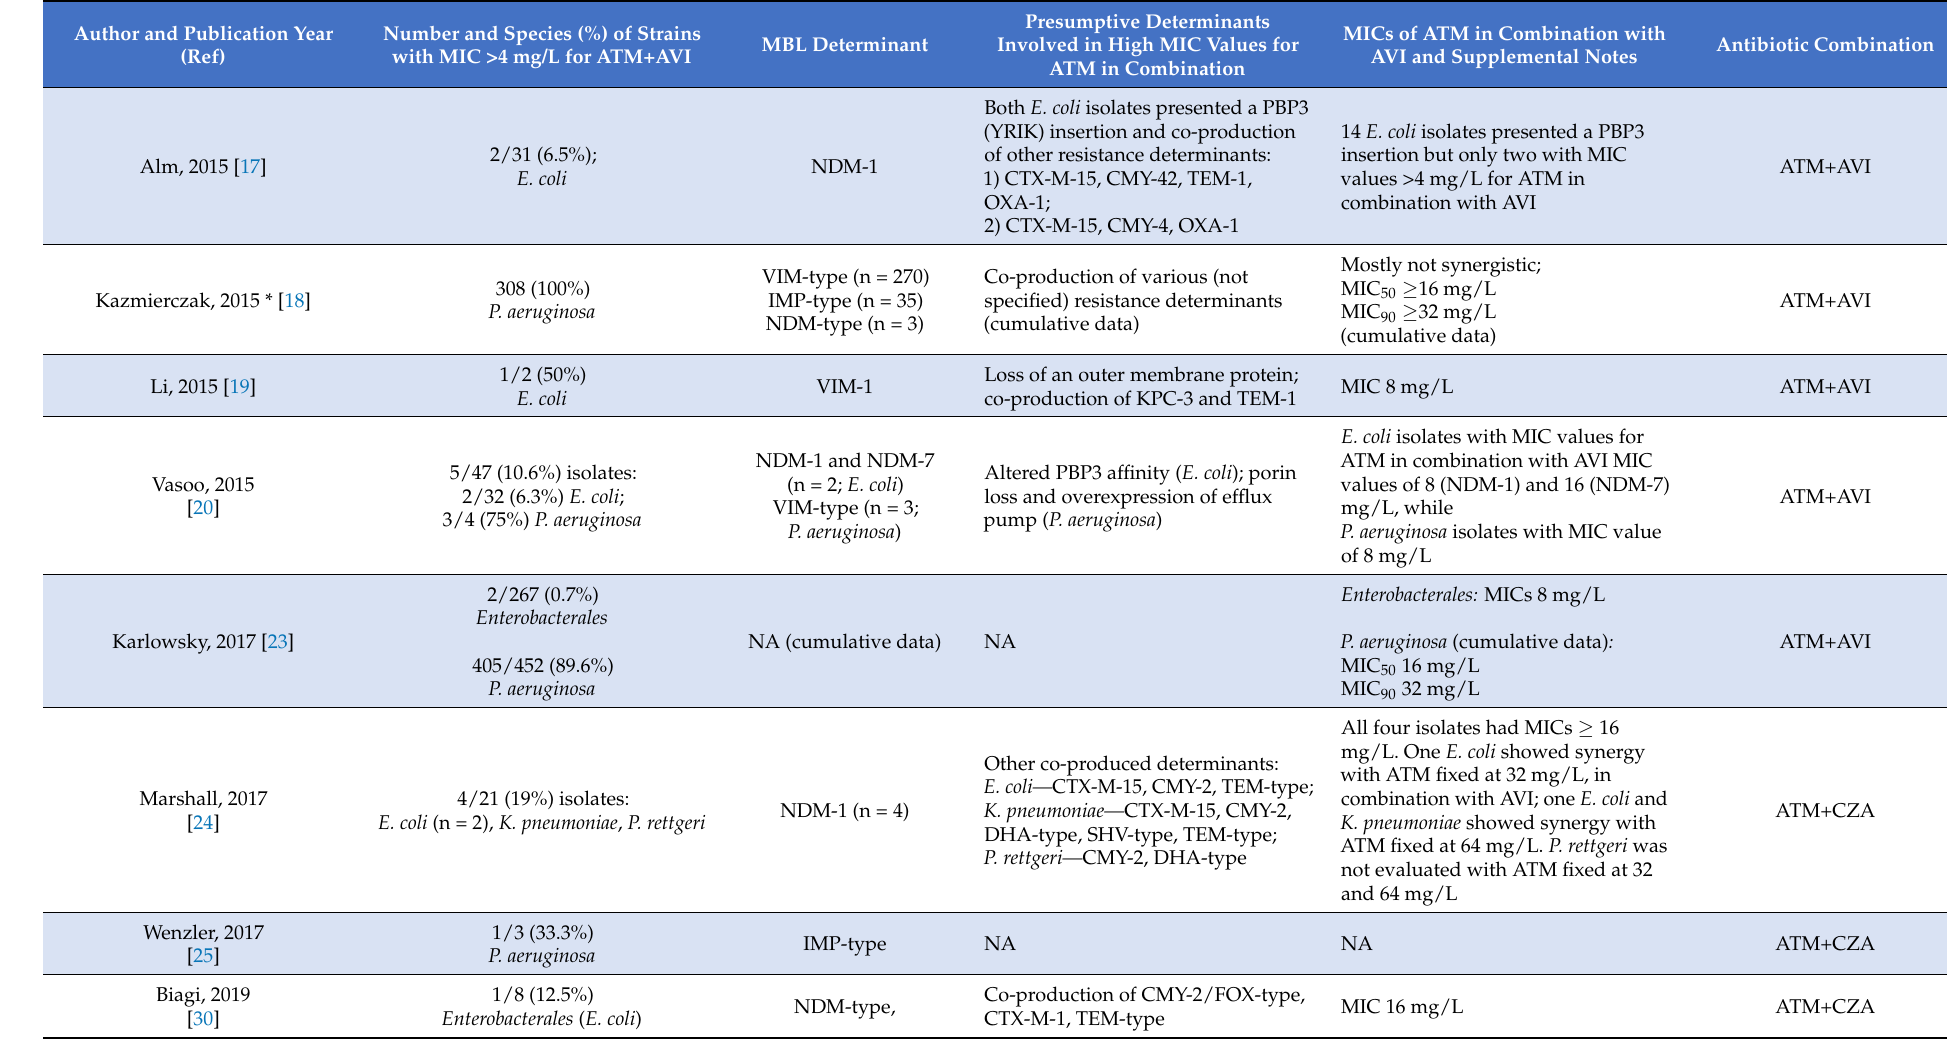
Table 2. Studies reporting low antimicrobial activity (MIC value > 4 mg/L) of ATM in combination with AVI or CZA against MBL-producing